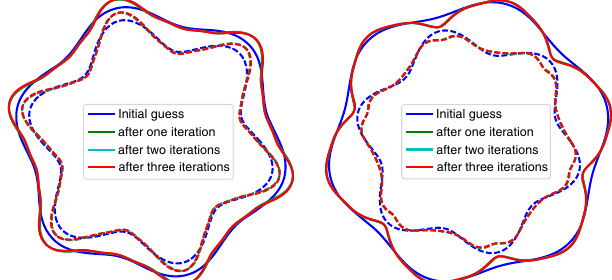
FIG. 5. Numerical solutions of the nonlinear, normal thickness variant for selected cases of film growth (left panel) and film shrinkage (right panel). Dashed lines show r − t and solid lines show r ; colors indicate iterations. The zeroth iteration, shown in blue, is a solution of the linear model [Eqs. (6) and (7)] with parameters as follows: ϵ ¼ 0 . 6 (left panel) − 0 . 6 (right panel),